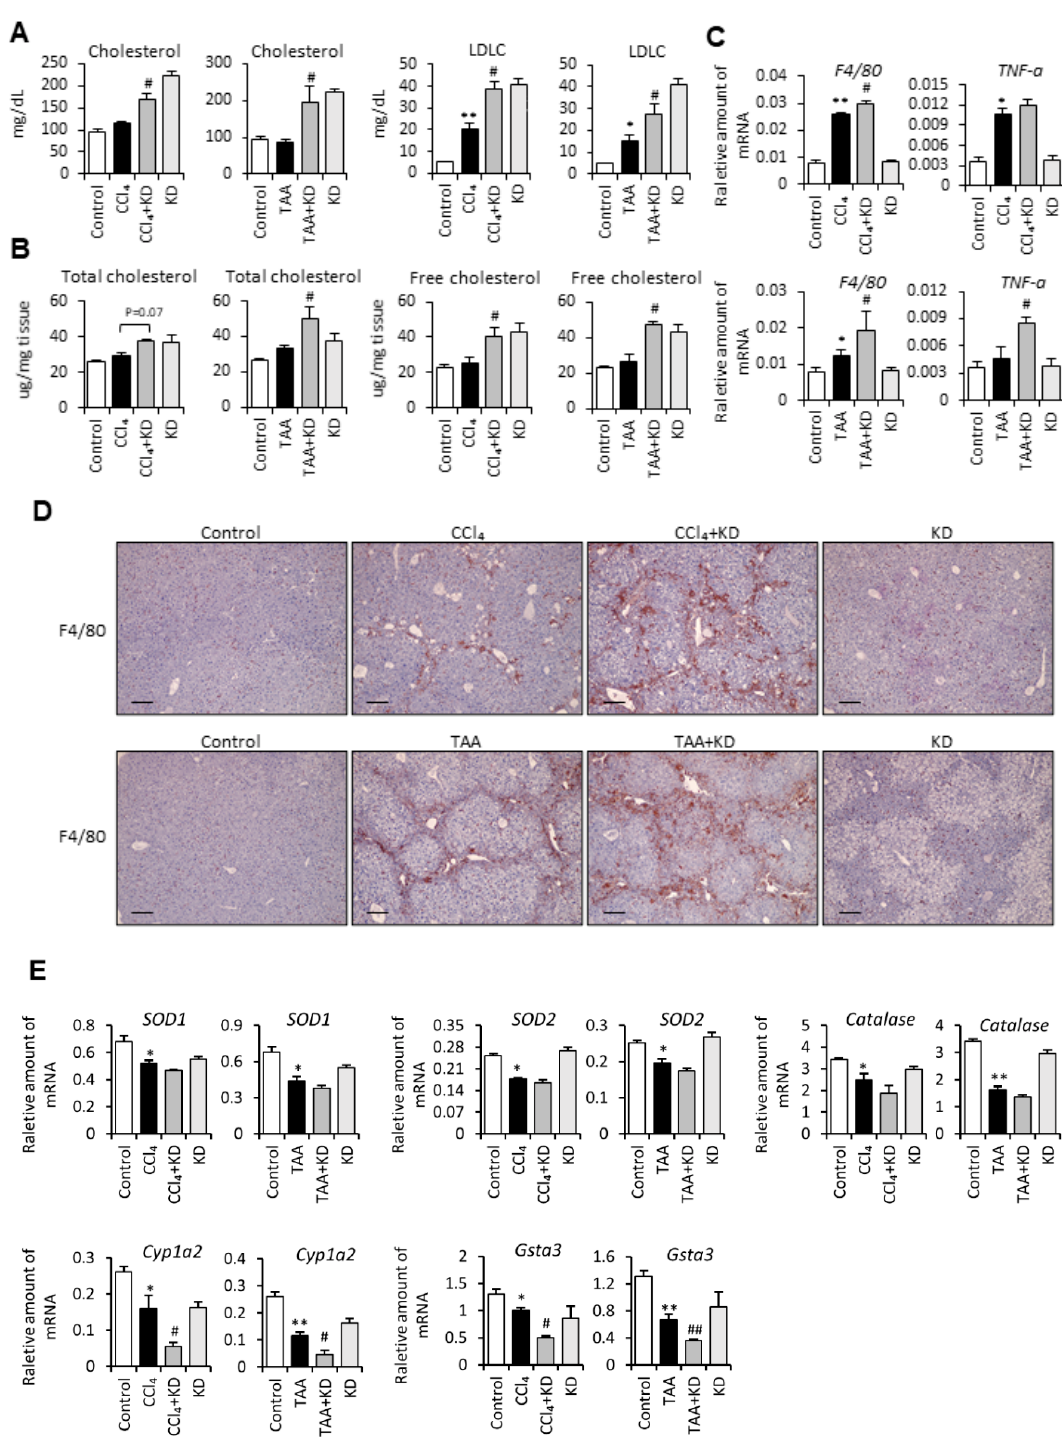
Figure 6. Ketogenic diet increased the cholesterol quantity and further enhanced CC l 4 - and TAA- induced liver fibrosis, liver inflammation, and the loss of antioxidant and detoxification ability. ( A ) Serum samples were collected at the end of the experiment, and the serum cholesterol and low-density lipoprotein cholesterol (LDLC) were assessed. ( B ) Intracellular total and free cholesterol were measured by using a colorimetric cholesterol quantification kit. ( C ) QPCR analyses of F4/80 and TNF- α gene expression. ( D ) Representative F4/80 immunohistochemistry staining of livers from each treatment group. Scale bars: 0.1 mm. ( E ) QPCR analyses of SOD1, SOD2, Catalase, Cyp1a2, and Gsta3 gene expression. *, p < 0.05; **, p < 0.01 vs. white bar. #, p < 0.05; ##, p < 0.01 vs. black bar. N = 5 in each group. Data are shown as means ± SEM.